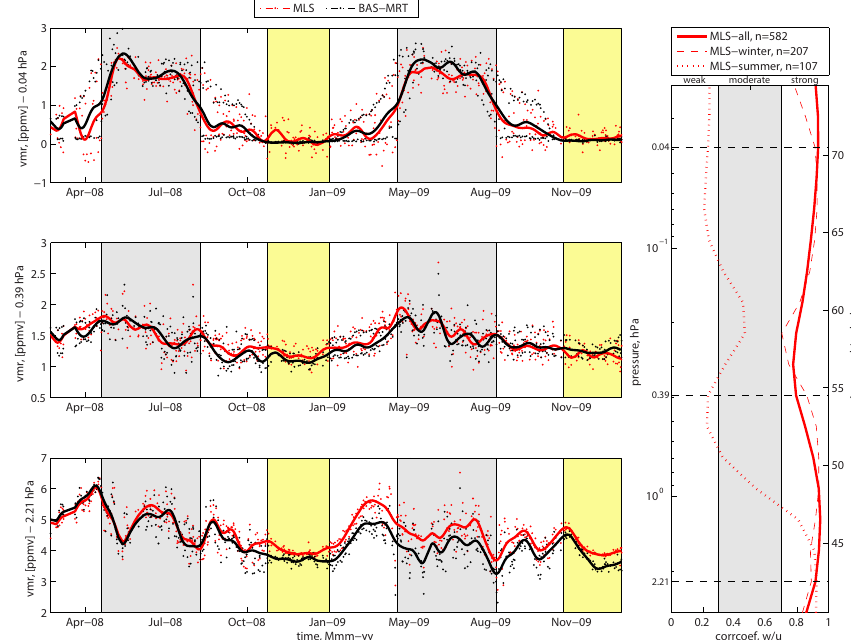
Figure 6. Time series of co-incident data between MLS and BAS-MRT at three independent pressure levels. Data are taken near 00 UTC and 15 UTC. Left panels: dots mark the individual data points for the datasets, and solid lines show the low-pass filtered data with a 20-day cut-o ff . Grey shading marks the winter season defined by solar elevation angles below − 30 ◦ , while yellow shading marks the summer defined by solar elevation angles above 0 ◦ . The areas without shading represent spring and fall, and in the mesosphere the diurnal signature can be seen in the data points. Right panel: calculated correlation coe ffi cients for the low-pass filtered data between BAS-MRT and MLS. The thick solid line is for the entire measurement period, while dashed and dotted lines represent the correlation coe ffi cients for the winter and summer respectively. The number of correlated data points ( n ) is listed in the legend for the respective